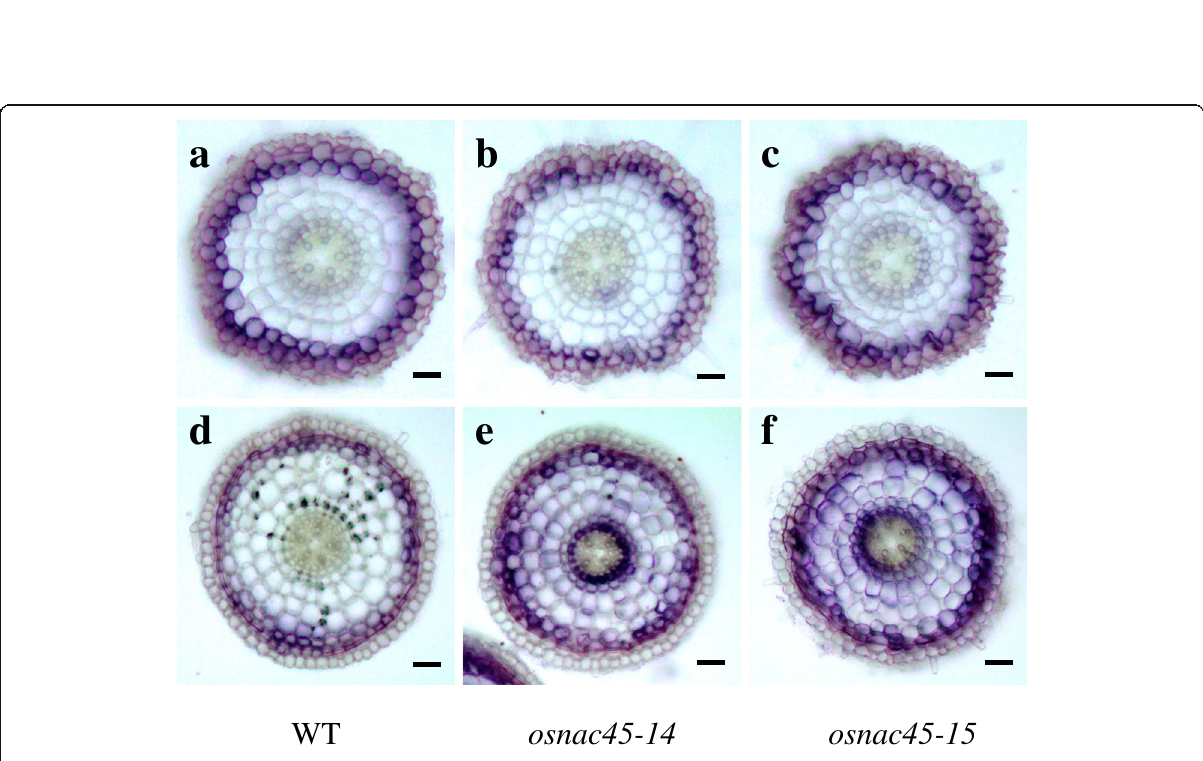
Fig. 6 NBT staining in the roots of 5-d-old WT and osnac45 seedlings under normal and salt conditions. a-c Cross section of WT, osnac45 – 14 and osnac45 – 15 under normal condition, respectively. d-f Cross section of WT, osnac45 – 14 and osnac45 – 15 under salt condition, respectively. Seedlings were treated with 100 mM NaCl for 24 h. Scale bar = 20 μ